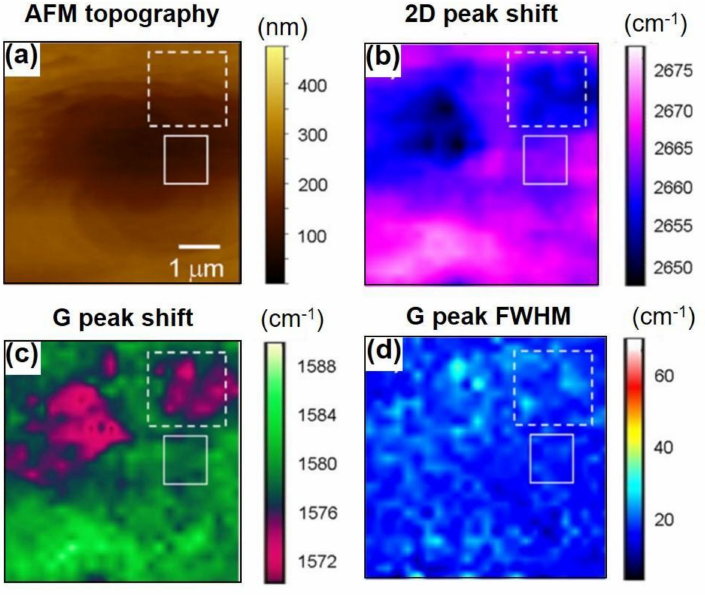
Figure 3. ( a ) AFM topography of monolayer on Cu substrate. ( b – d ) were the corresponding Raman images of 2D, G peak shift and G peak-FWHM (G peak Full-Width @ Half Maximum). Dashed square regions in each image indicated that the irregular fixture from AFM topography played a cardinal role to red-shift the 2D and G peak location. It could be compared to the solid square region between 2D- and G-peak shift, where the 2D peak was stronger blue-shifted than the G-shift, meaning that mechanical strain effect is more influential. The doping effect of deposited CVD-MG from underlying Cu substrate was not evident in terms of both stronger 2D peak shift than the G peak case and the vague relationship between G-shift and G-FWHM. Reprinted with permission from Ref.